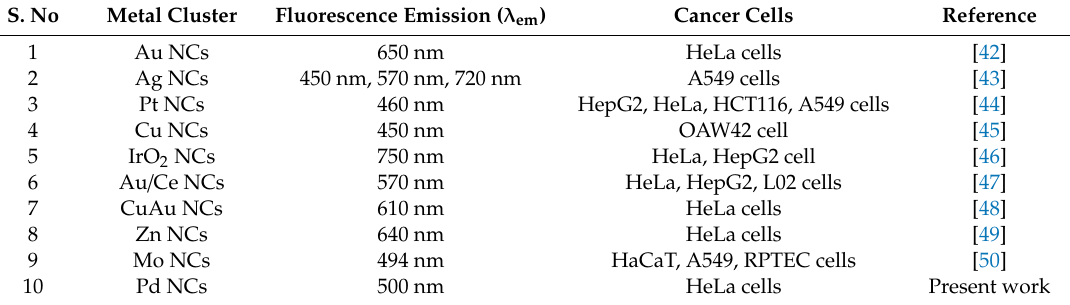
Figure 8. Translocation of Pd NCs inside the HeLa cell nucleus. ( A , B ) represent the confocal laser scanning optical microscope (CLSM) image and mean fluorescence intensities from nucleus and cytoplasm respectively. Table 1. Comparison of literature reported metal nanoclusters as intracellular fluorescent markers for visualization of cancer cells.